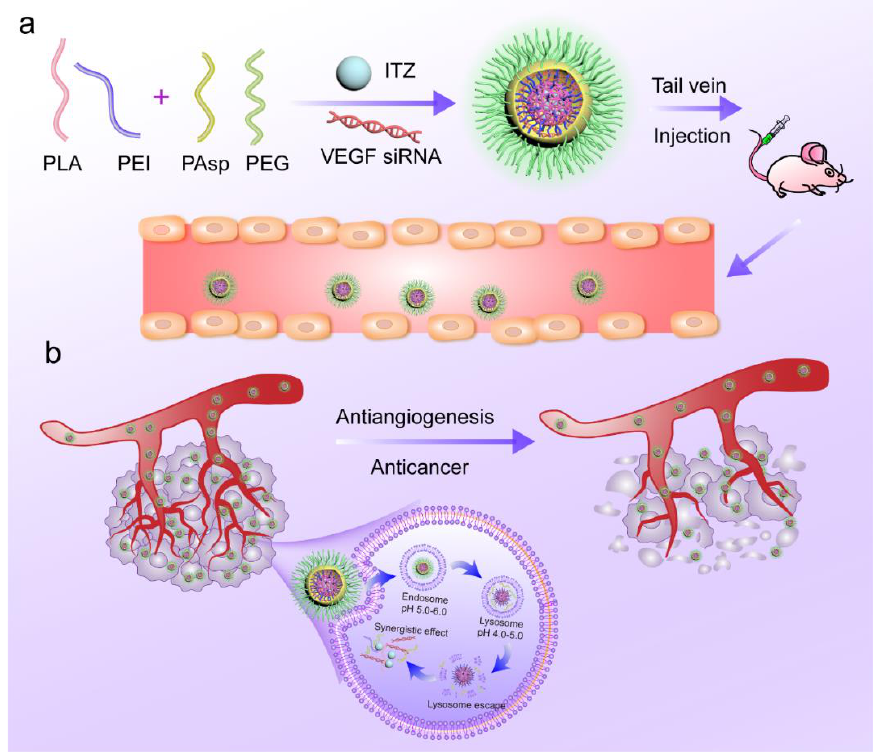
Figure 1. ( a ) ITZ-VEGF siRNA-loaded composite nanoparticle delivery system. ( b ) Schematic of the intracellular therapeutic mechanism of the ITZ-VEGF siRNA composite nanoparticles.